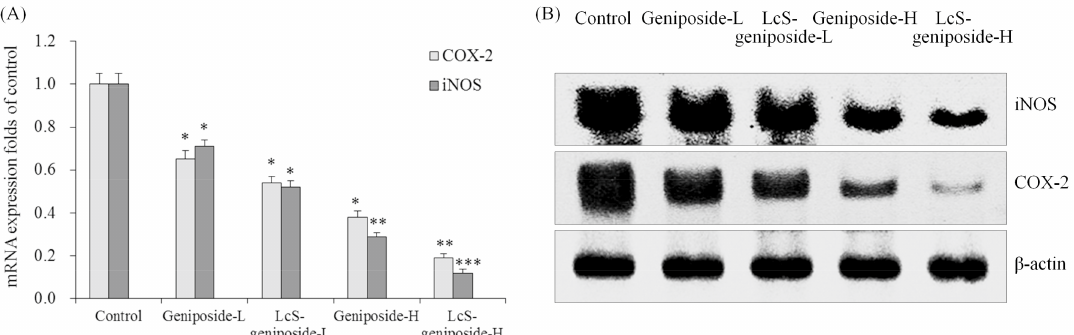
Figure 10. The mRNA ( A ) and protein ( B ) expressions of COX-2 and iNOSin human oral squamous carcinoma HSC-3 cells. * p < 0.05, ** p < 0.01, *** p < 0.001 vs. the control group. Geniposide-L: 25 µ g/mL geniposide; LcS-geniposide-L: 1.0 × 10 6 CFU/mL LcS + 25 µ g/mL geniposide; Geniposide-H: 50 µ g/mL geniposide; LcS-geniposide-H: 1.0 × 10 6 CFU/mL LcS + 50 µ g/mL